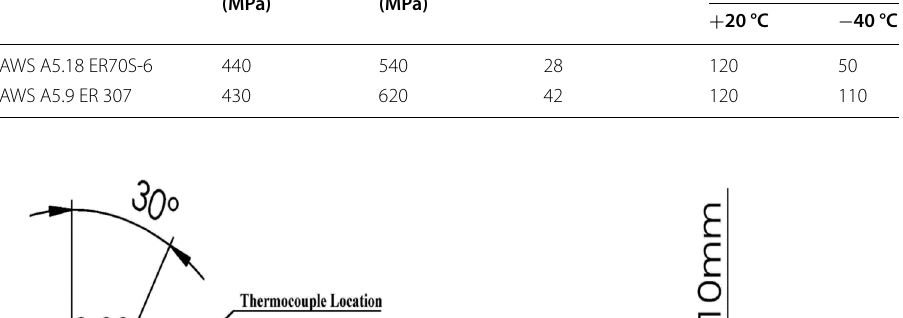
Table 4 Mechanical properties of all weld metals of filler wires [34] Weld metal type